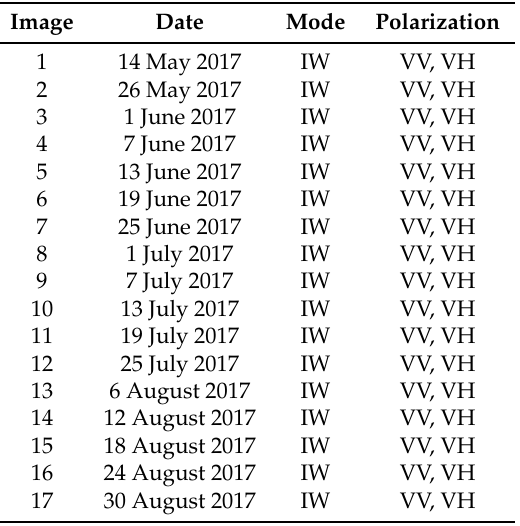
Table 1. List of Sentinel-1 scenes used in the study.